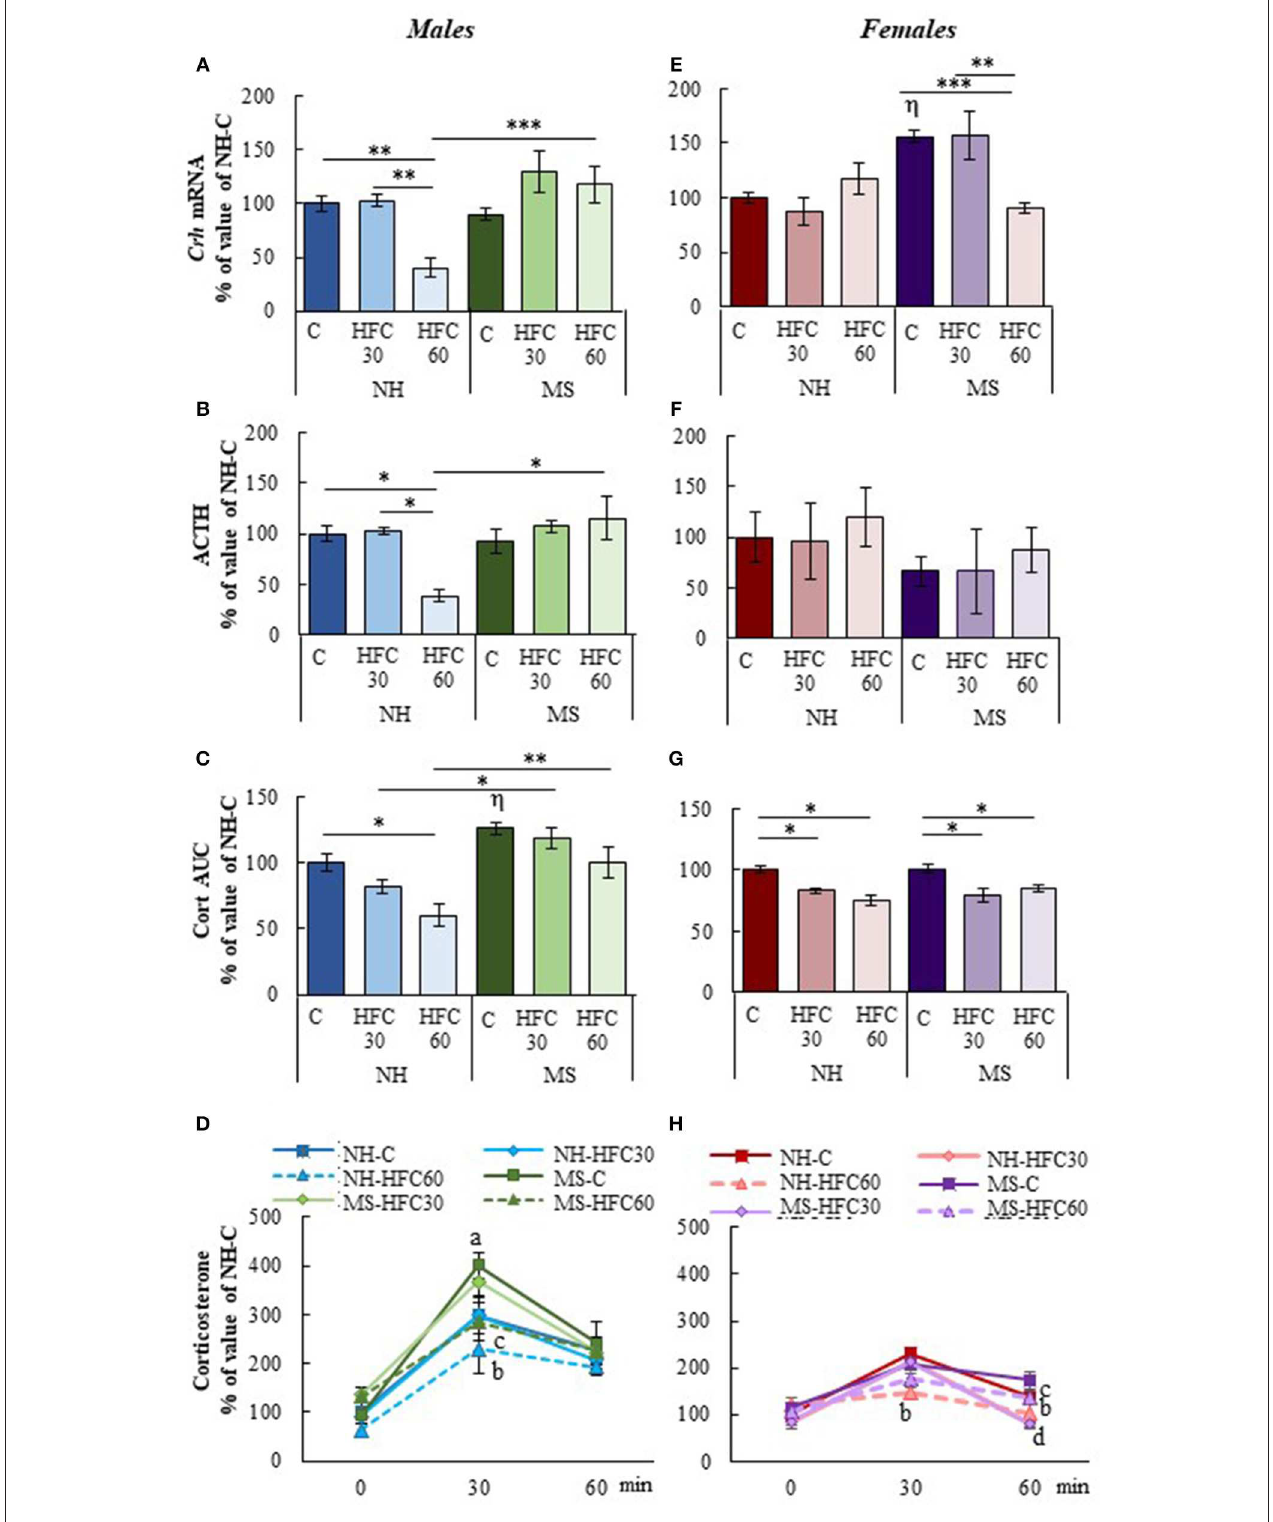
FIGURE 3 | Effect of maternal separation and a high-fat/high-carbohydrate diet on HPA axis parameters in acutely restrained rats. Non-handled (NH) or maternal separated (MS) male and female rats fed a chow (C) or a high-fat/high-carbohydrate diet (HFC) from Pd30 (HFC30) or 60 (HFC60) until Pd160 were restrained 1h